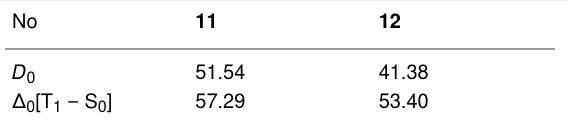
Table 2: Ground state bond dissociation energies ( D 0 ) and adiabatic excitation energies, Δ 0 [ Τ 1 − S 0 ] for 11 and 12 . All numerical values in kcal/mol, in aqueous